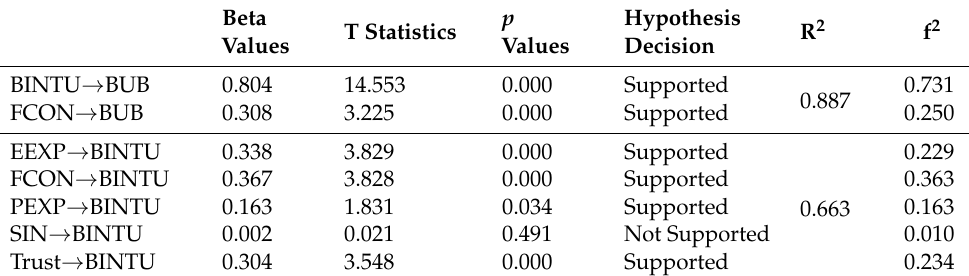
Table 8. Structural equation modelling (SEM)